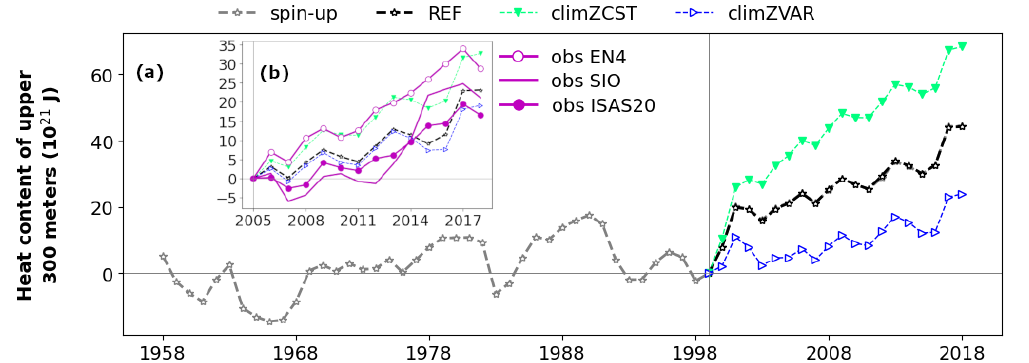
Figure 1. Modelled tropical [35 ◦ S–35 ◦ N] heat content of upper 300m (OHC300; in 10 21 J (hereafter ZJ) for each simulation described in Table 1: REF (black; empty stars), climZCST (green; full downward triangles) and climZVAR (blue; empty rightward triangles). In (a) , the final part of the spin-up has been added in grey to illustrate the branching protocol in year 1999, and OHC300 anomalies have been computed with respect to year 1999. Subplot (b) zooms over the Argo period to compare modelled tropical OHC300 anomalies with three in-situ-based products (see Sect. 2.3). Table 1. Experimental set-up. Simulation Which CHL fields interact with incoming shortwave radiation? PLF nature REF Interactive